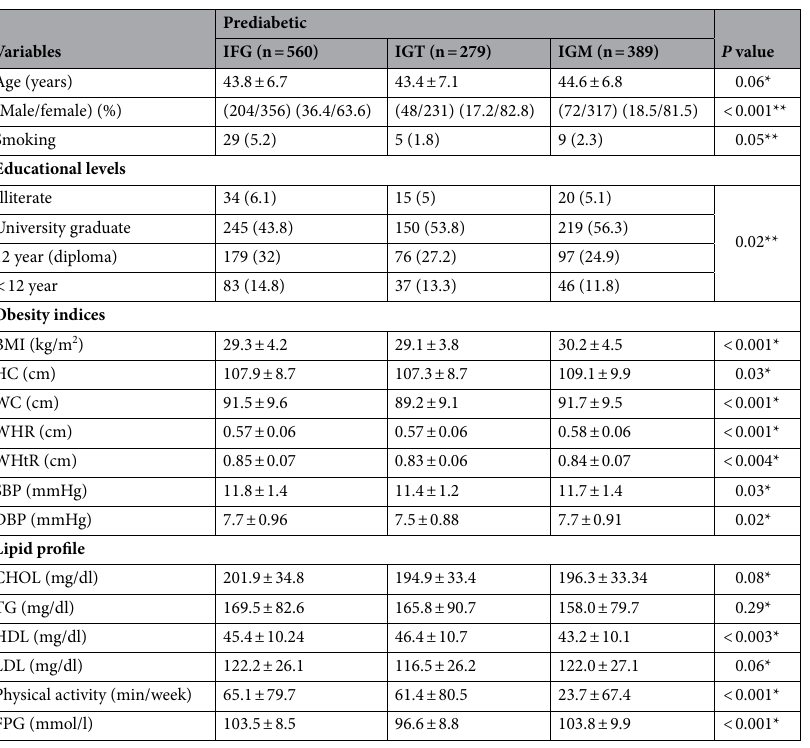
Table 1. Basic demographic and clinical characteristics of different categories of subjects at the baseline. Values are mean ± SD for continuous and frequency (%) for categorical variables. IGT impaired glucose tolerance, IFG impaired fasting glucose, IGM impaired glucose metabolism; including subjects with IGT and/ or IFG, BMI Body mass index, HC hip circumference, WC waist circumference, WHR waist to hip ratio, WHtR waist to height ratio, SBP systolic blood pressure, DBP diastolic blood pressure, CHOL total cholesterol, TG triglycerides, HDL high-density lipoprotein cholesterol, LDL low-density lipoprotein cholesterol, FPG fasting plasma glucose. *ANOVA test, **Chi-square test, P < 0.05 is considered as